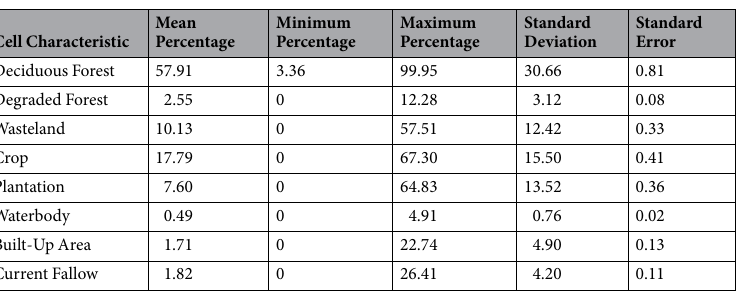
Table 2. Landuse characteristics of the intensive study